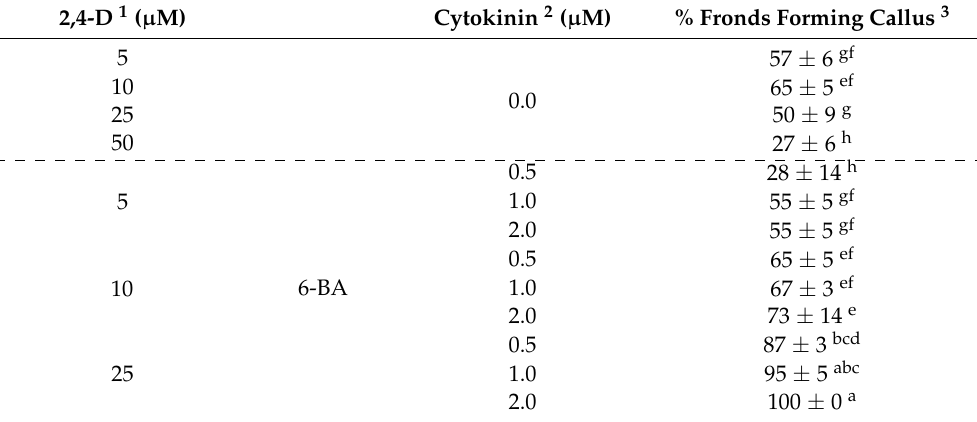
Table 1. The effects of the type and concentration of plant growth regulators on callus induction from fronds after 10 weeks in